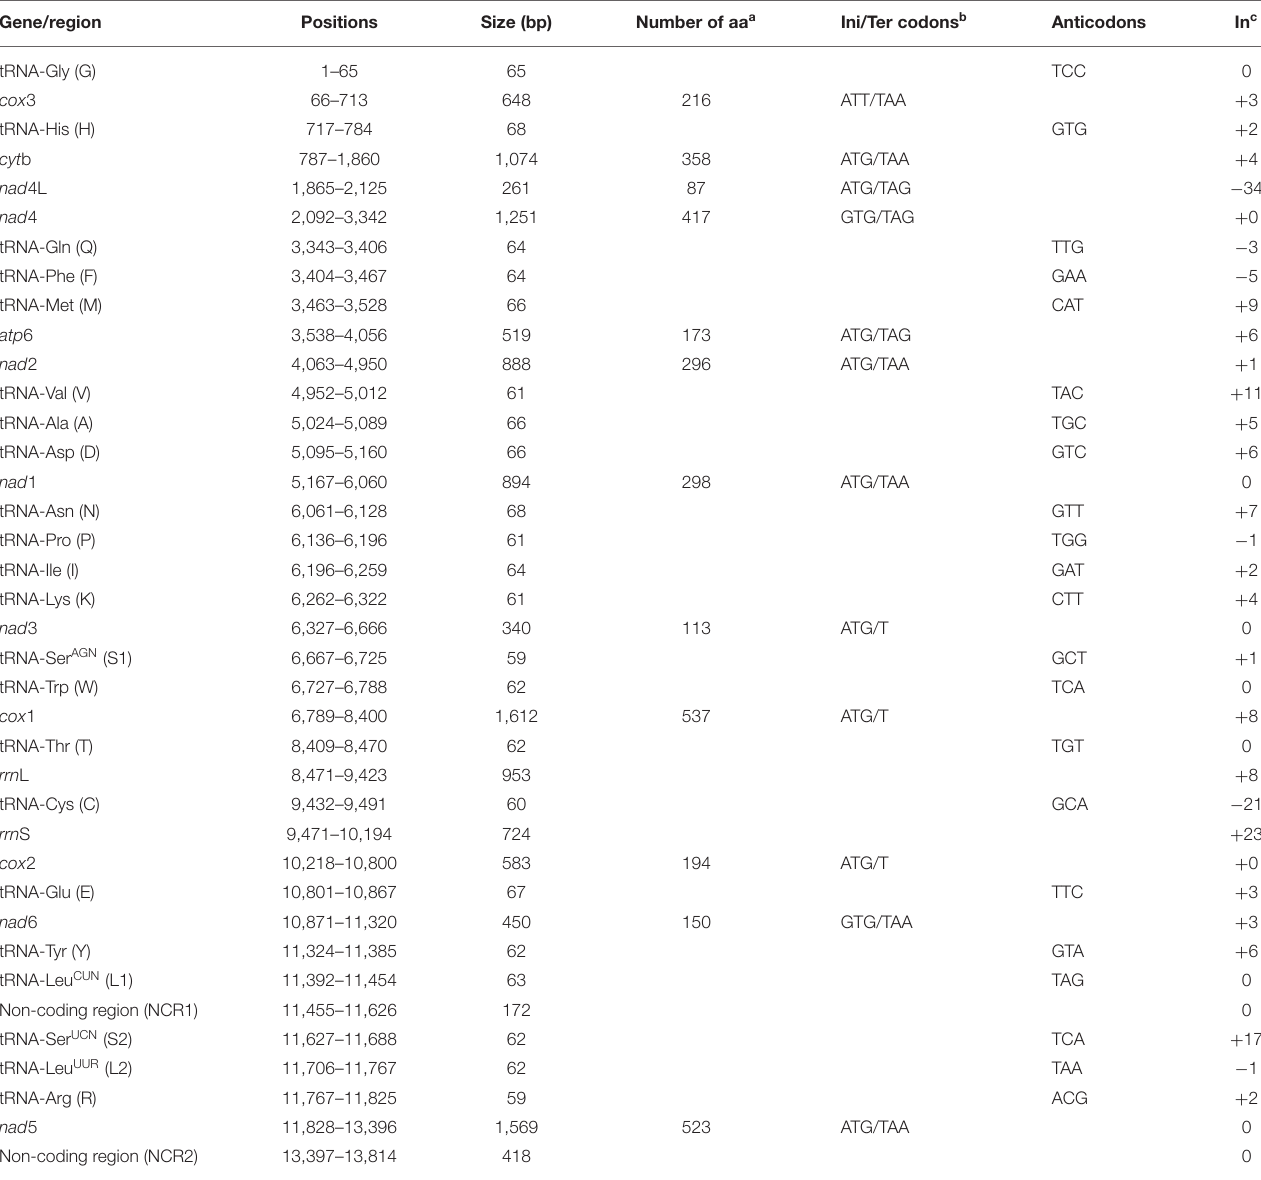
TABLE 1 | The organization of the mitochondrial (mt) genome of Hydatigera taeniaeformis . Gene/region Positions Size (bp) Number of aa a Ini/Ter codons b Anticodons In c tRNA-Gly